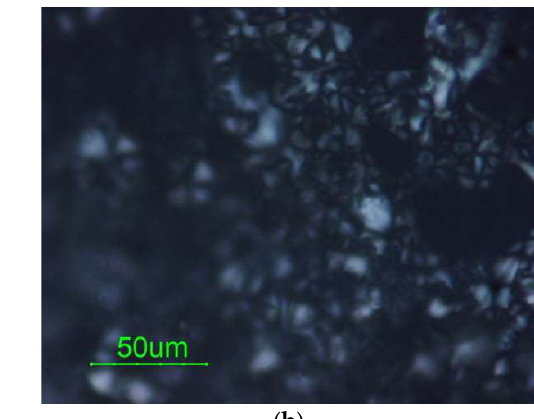
Figure 6. Droplet size distribution for a water content of 20.0% in the dilution line S/O 25/75 at 30 °C. All refers to the whole dispersed system (O + LC) and Only LC to the liquid crystal phase only.